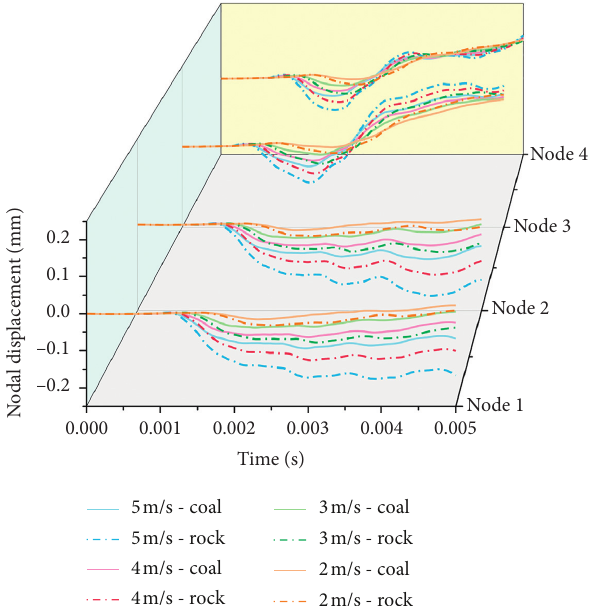
Figure 16: Nodal displacement in the tail beam noncollision contact zone under different impact speeds.